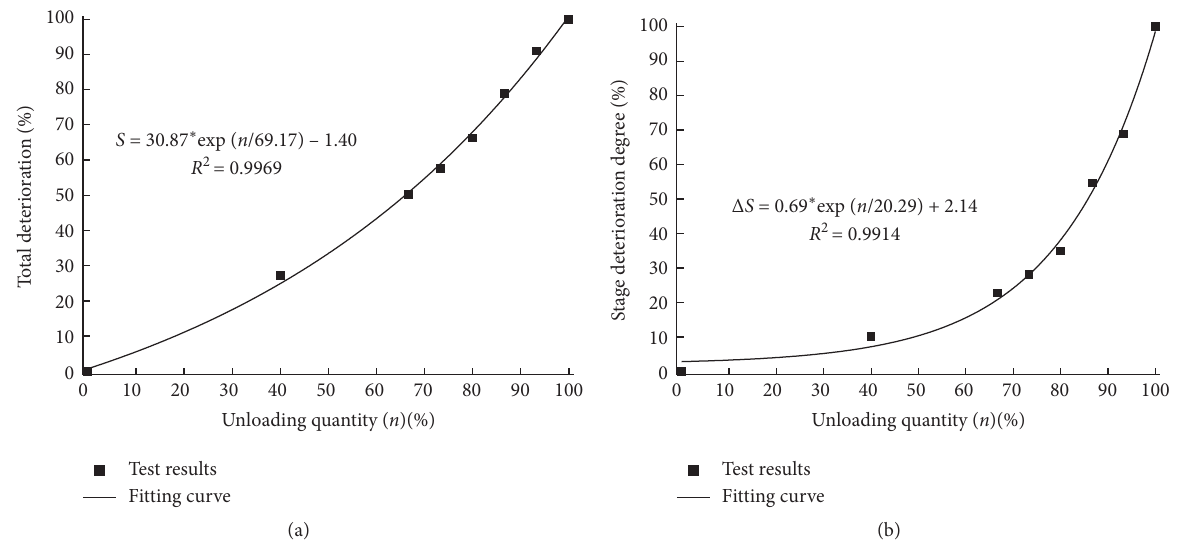
Figure 13: Axial strain energy density damage deterioration degree and unloading quantity. (a) Total deterioration degree of axial strain energy density and unloading quantity. (b) Stage deterioration degree and unloading quantity in the axial strain energy density